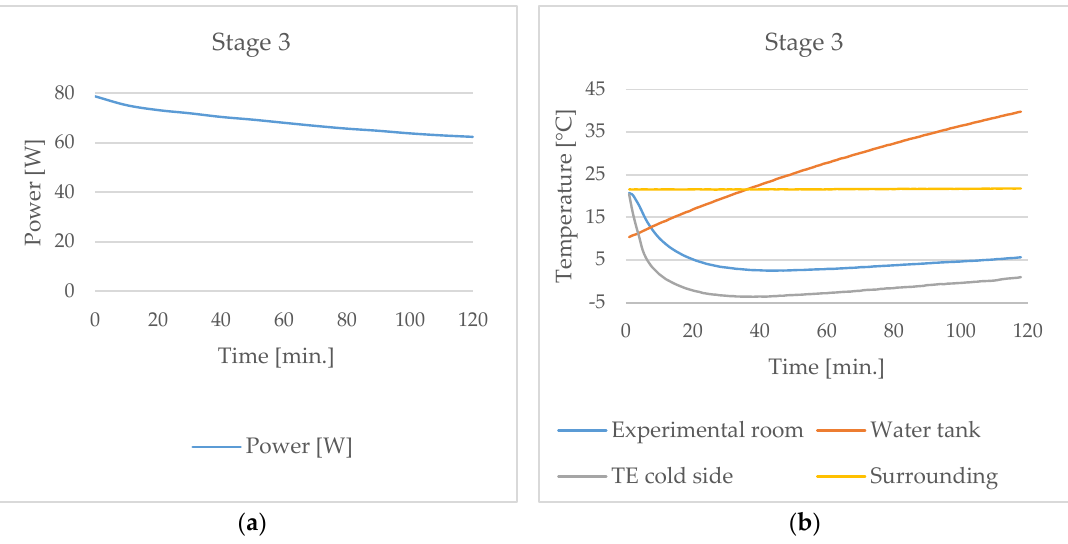
Figure 6. The results obtained during the measurements conducted at Stage 3: ( a ) mean power supplied to the TE module; ( b ) mean temperature values measured at fix points of the experimental set.